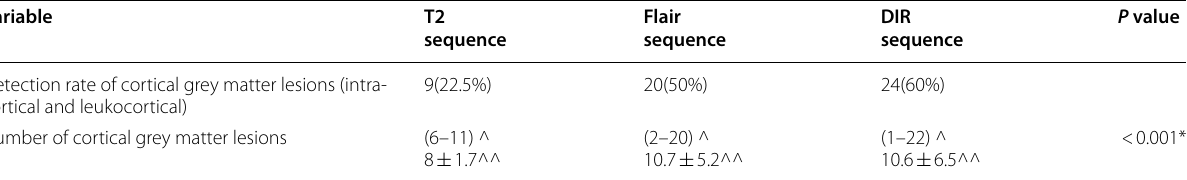
Table 5 Agreement between DIR, T2 and Flair results as regarding diagnostic accuracy parameters among studied 40 MS patients